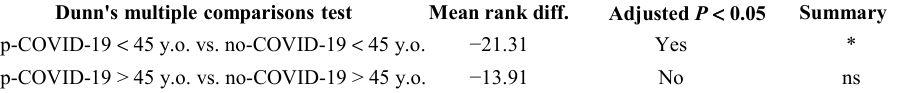
Figure 3. Relationship between plasma 25(OH)D levels and BMI among p-COVID-19 ( A ) and no COVID-19 ( B ) participants; * p = 0.357, ns = not signi fi cant; r = correlation coe ffi cient.